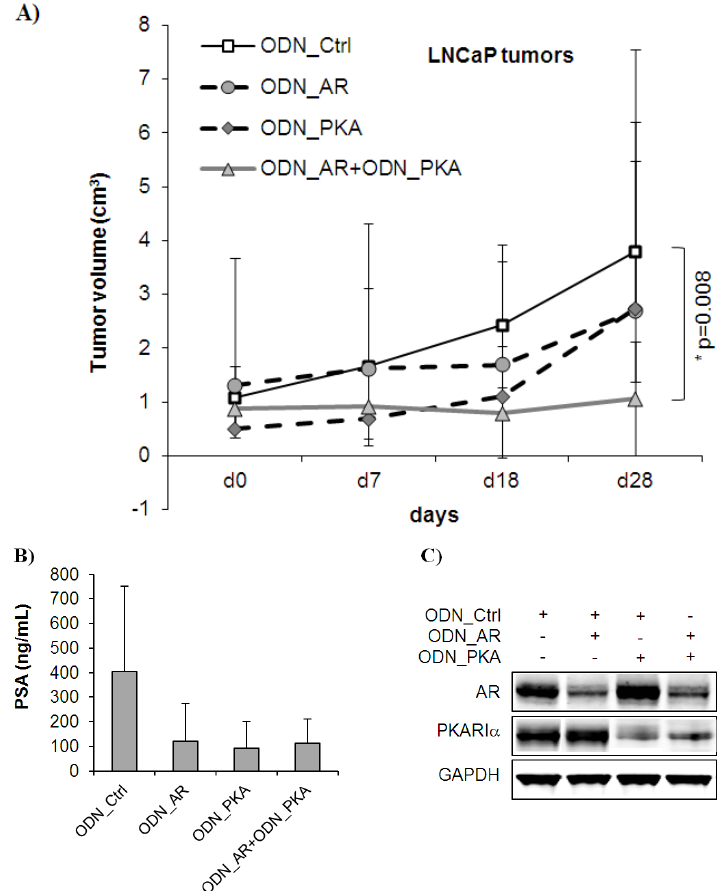
Figure 3. Single and combined targeting of AR and PKARI α in LNCaP tumors in vivo . Tumors were established by subcutaneous injection of LNCaP tumor cells and matrigel in a ratio of 1:1. ODNs were injected intraperitoneally at a final concentration of 10 mg/kg mouse three times in the first and two times in the following three weeks. For single treatments, ODNs were administered at a concentration of 5 mg/kg mouse together with 5 mg/kg mouse ODN_Ctrl. In the control group, mice received 10 mg/kg mouse ODN_Ctrl. ( A ) Tumor volumes were measured with a caliper weekly. The graph shows mean tumor volume ± S.E.M. After four weeks, tumors, which were treated with the combination of ODN_AR and ODN_PKA, were significantly smaller ( n = 12, * p = 0.008, Mann Whitney- U test) than those treated with the ODN_Ctrl ( n = 8). Single treatment with either the ODN_AR ( n = 8) or the ODN_PKA ( n = 9) resulted in moderate tumor growth inhibition compared to the control; ( B ) For PSA measurements, blood was taken after four weeks of treatment via the tail vein, and serum PSA levels were determined by Advia CentaurXP Immunoassay System. Values were indicated as ng/mL ± SD; ( C ) Expression of AR and PKARI α was analyzed by Western blotting of tumor lysates obtained after one week of treatment. Protein values were normalized with